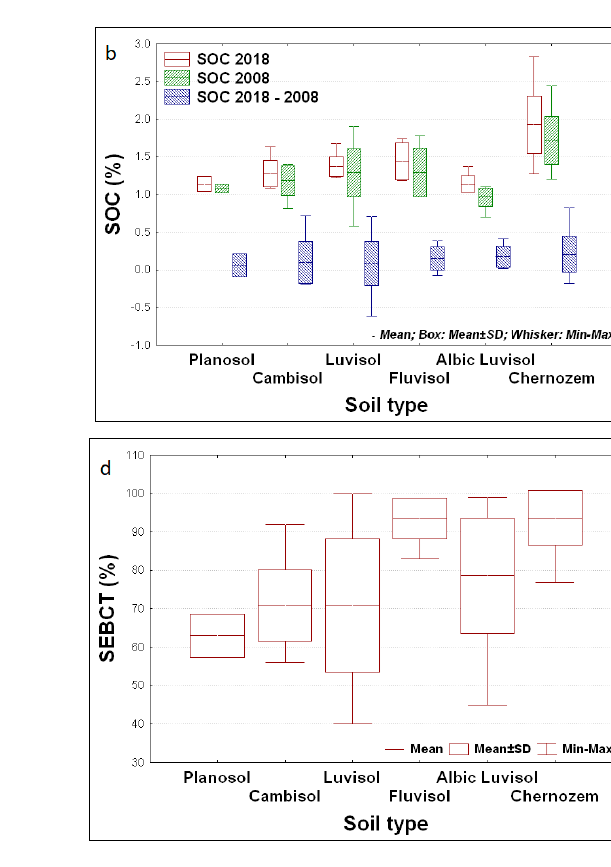
Figure 3. The values of the ( a ) pH (KCl), ( b ) SOC, ( c ) HWEC and ( d ) SEBCT in 2008 and 2018 according to the soil type. According to the individual soil types, the average soil granularity (%) ranged from 13.7% (Albic Luvisol) to 24.8% (Planosol) in the first category (0.001–0.01 mm). In the second category (0.25–2.00 mm), the average values ranged from 1.3% to 3.9% (Cherno- zem, Albic Luvisol, Haplic Luvisol, Fluvisol), and the last category ranged from 16.4% to 20.7% (Planosol, Cambisol); see Supplementary Materials (Figure S1). The average an- nual doses of N, applied in fertilisers for the period 2008–2018 ranged from 121.2 kg ha − 1 (Planosol) to 157.2 kg ha − 1 (Luvisol) at all localities. The N applied in the form of mineral fertilisers is similar to the total N. The average input of total P into the soil in fertilisers ranged from 19.7 kg ha − 1 (Fluvisol) to 47.6 kg ha − 1 (Chernozem). The average input of total K ranged from 12.0 kg ha − 1 (Cambisol) to 69.1 kg ha − 1 (Luvisol). The highest average input P was recorded on the soil type Planosol (186.5 kg ha − 1 ); see Supplementary Materials (Figure S2, S3). 3.2. Basic Relationship between the Soil Parameters (Simple Linear Regression) Based on regression modelling, a model of the dependence of the pH difference between 2008 and 2018 (pH 2018 minus pH 2008) on the doses of organic material (OM) applied in digestate for the experimental field across soil types was developed. The modelling confirmed that the increase of digestate caused the pH decline; see Figure 3 (Box-Plot). Parameters of the model were as follows: the equation of the straight-line re- lating Difference pH 2018–2008 and Digestate OM, estimated as pH difference 2018–2008 = ( − 0.0373) + ( − 0.5490) * Digestate OM using the 60 observations in this dataset. The y-intercept, the estimated value of the Difference pH 2018–2008 when Digestate OM is zero, is − 0.0373 with a standard error of 0.0956. The slope, the estimated change in the Difference pH 2018–2008 per unit change in Digestate OM, is − 0.5490 with a standard error of 0.1829. The value of R-Squared, the proportion of the variation in Difference pH